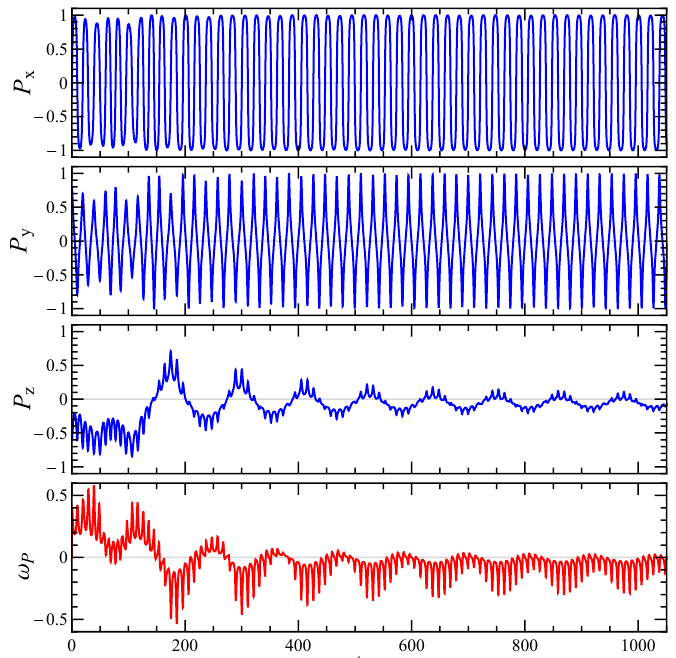
Figure 5. Time evolution of the components of the particle smallest principal axis of inertia P and of the angular velocity around it ω P , for an initial orientation far from the vorticity axis z . The aggregate is the one reported in Figure 1b, the other parameters are N p = 20, D f = 1.5, and n = 1.0.